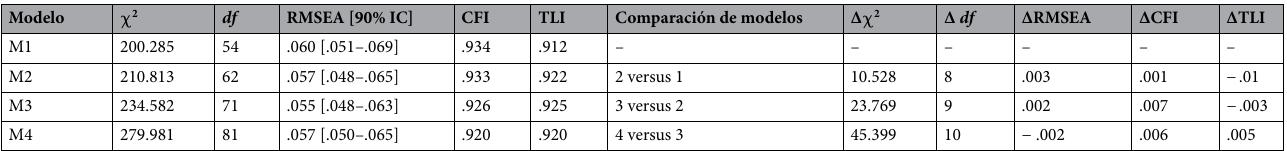
Table 3. Goodness of fit indexes of the invariance models. χ 2 , Chi-square; df, degrees of freedom; RMSEA, root mean square error of approximation.; CFI, confirmatory fit index; TLI, Tucker–Lewis index; * p < .01; Model 1, configural invariance (M1, no restrictions), Model 2, metric invariance (M2, restriction on factorial loads); Model 3, strong invariance (M3, restriction on factorial loads and intercepts); Model 4, strict invariance (M4, restriction on factorial loads, intercepts and error